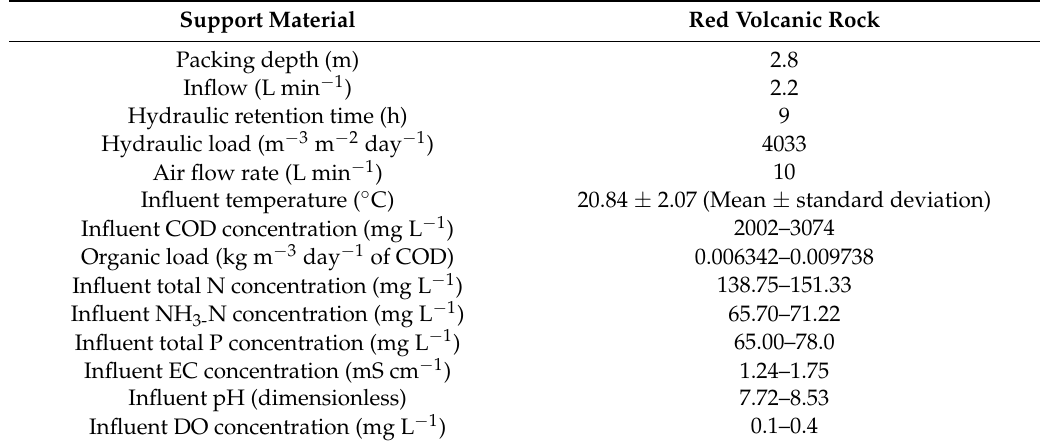
Table 1. General operating